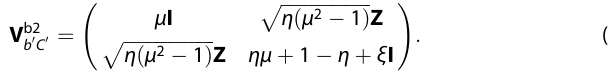
p ffiffiffiffiffiffiffiffiffiffiffiffiffiffiffiffiffiffiffiffi η ð μ 2 (cid:1) 1 Þ